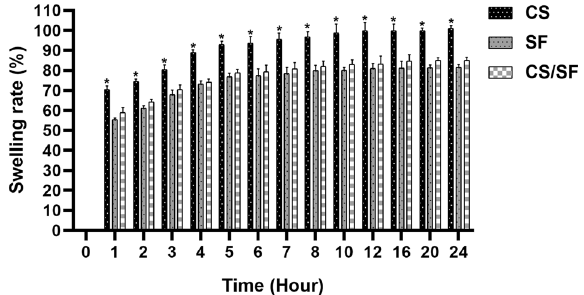
Fig. 4 The swelling rate of scaffolds. The fi gure shows a similar swelling pattern among all samples within 24 h. However, CS shows a signi fi cant water uptake in all time intervals compared with SF and CS/SF samples ( P < 0.0001). There are no considerable differences between SF and CS/SF samples in all predetermined time intervals. * represents a signi fi cant difference with SF and CS/SF ( P < 0.0001)